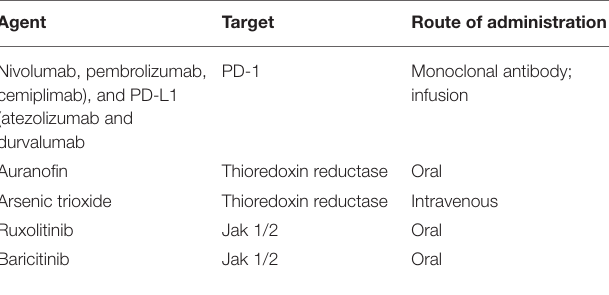
TABLE 1 | Summary of anti-cancer agents that have been explored for the indication of HIV.